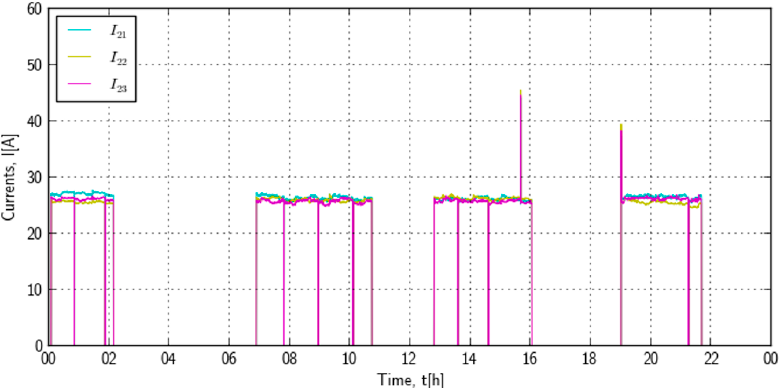
Figure 17. The diagrams of the load current changes of PU2 recorded on 23 June 2009.